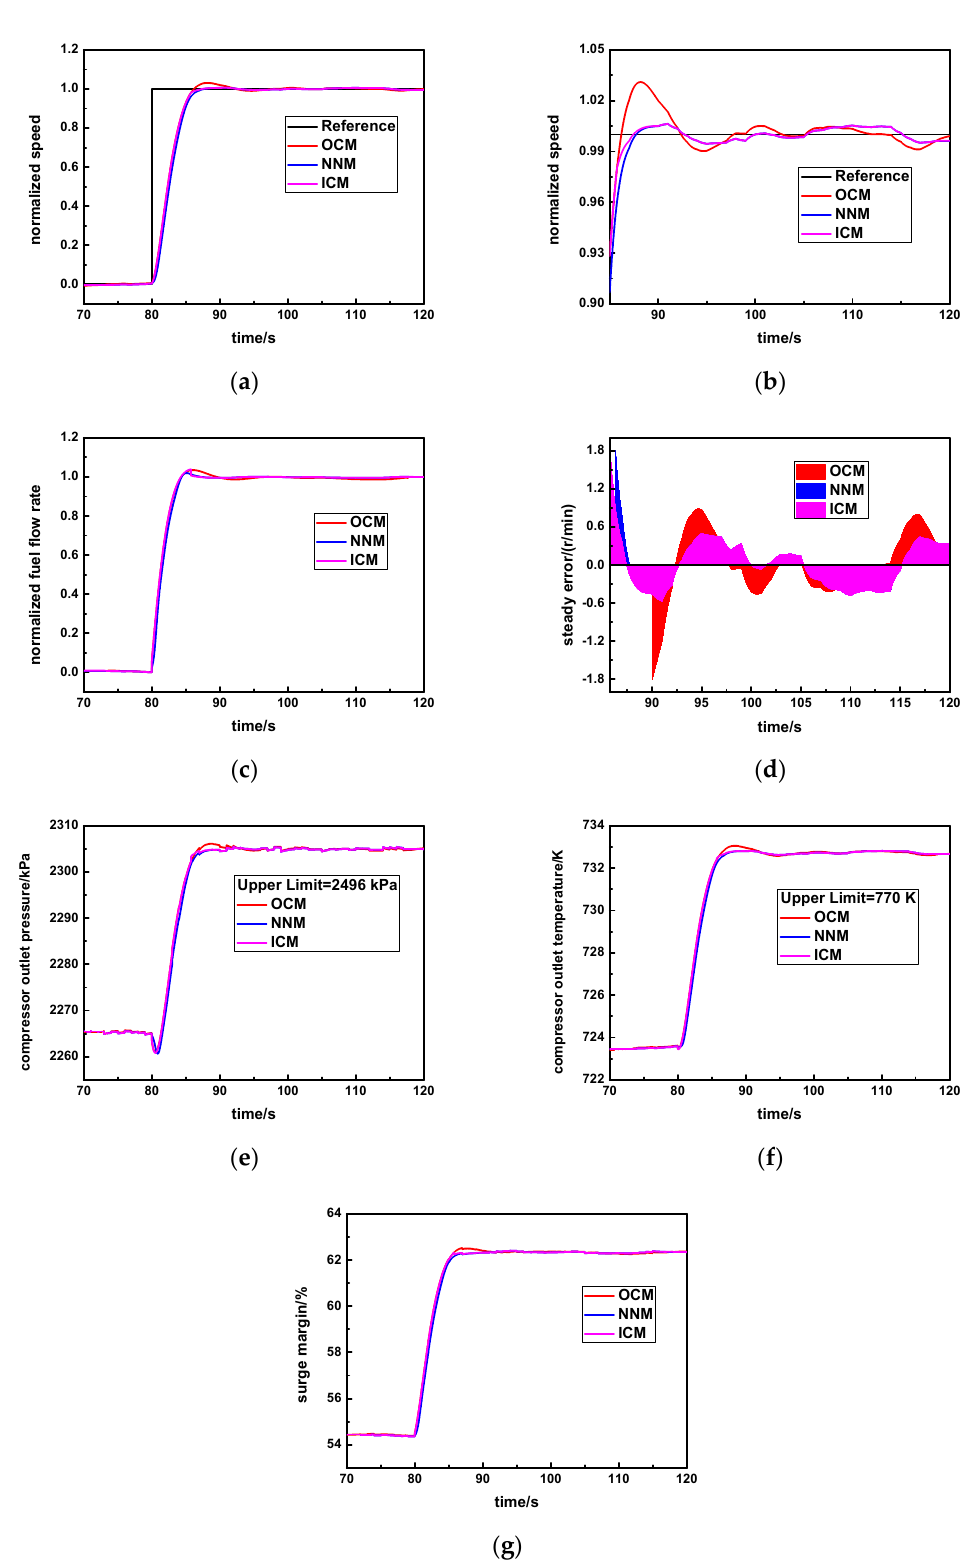
Figure 13. Related parameters distribution of first robustness test. ( a ) Speed response curve, ( b ) Locally enlarged speed curve, ( c ) Fuel flow rate curve, ( d ) Steady error of first robustness test, ( e ) Compressor outlet pressure, ( f ) Compressor outlet temperature, ( g ) Surge margin of compressor.